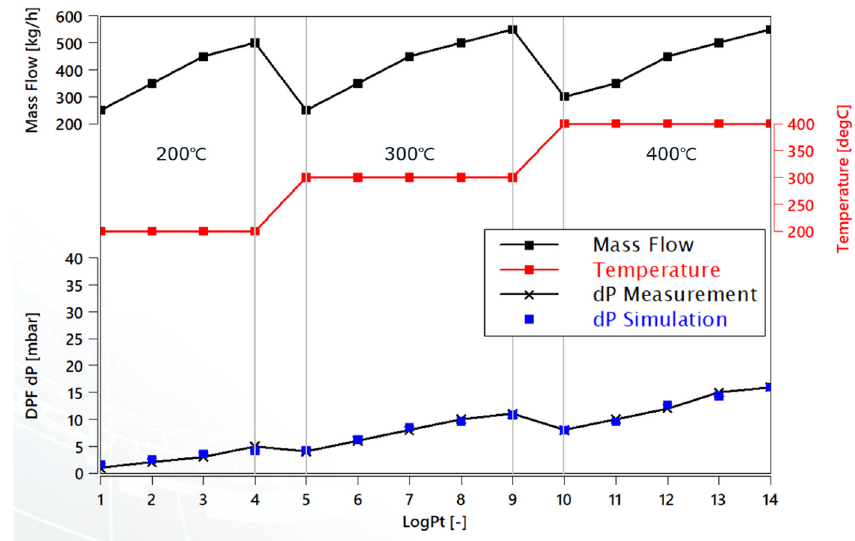
Figure 7. Differential pressure of clean DPF and boundary conditions.